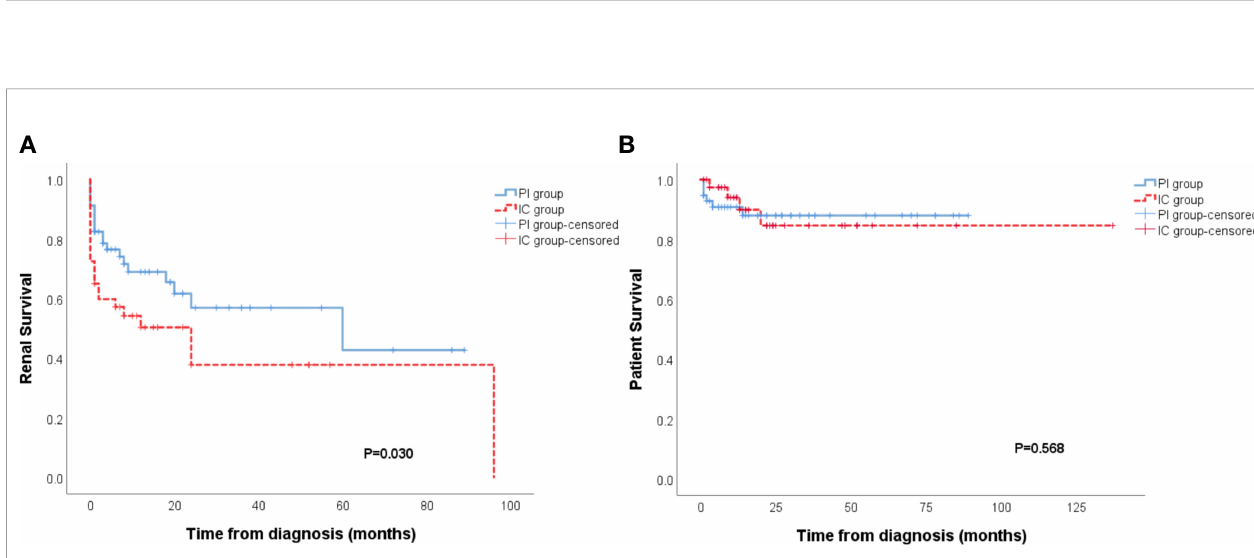
FIGURE 1 | Patients with low sC3 showed worse renal outcomes than patients with normal sC3 level at diagnosis (p = 0.003) (A) . Patients who persist with low sC3 exhibit a substantially higher degree of ESRD than the patients whose sC3 level returned to normal during the treatment process (p = 0.013) (B) . The patient survival of patients with low sC3 at diagnosis and persists with low sC3 in the treatment (C, D) .